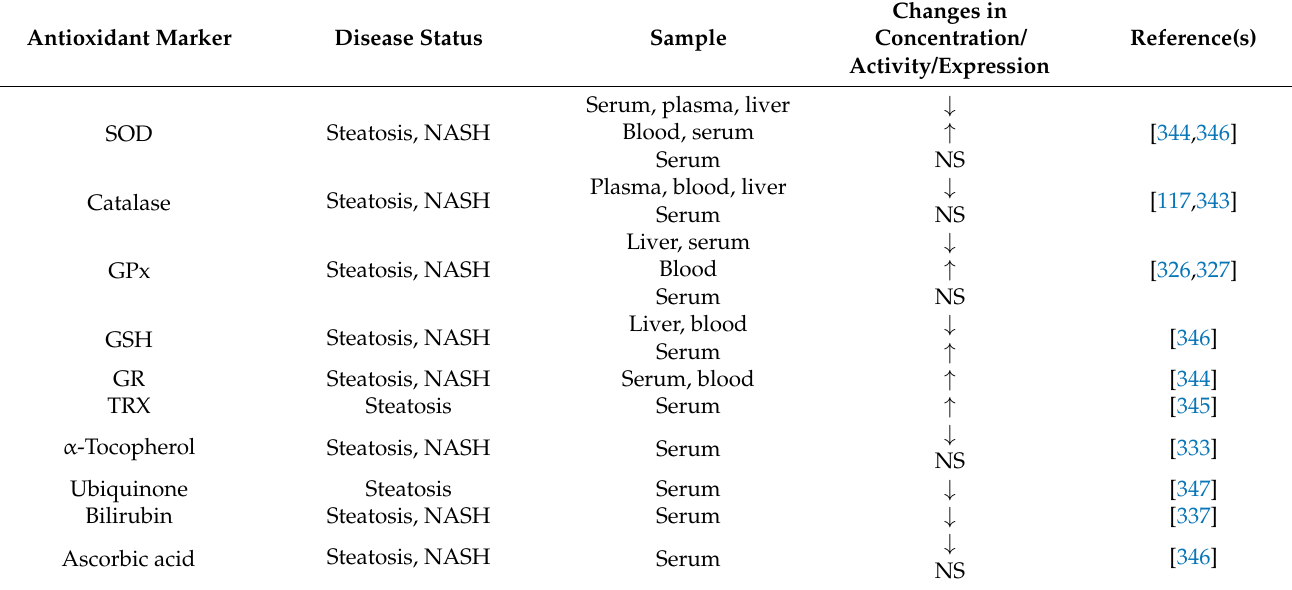
Table 4. Antioxidant markers in NAFLD/NASH